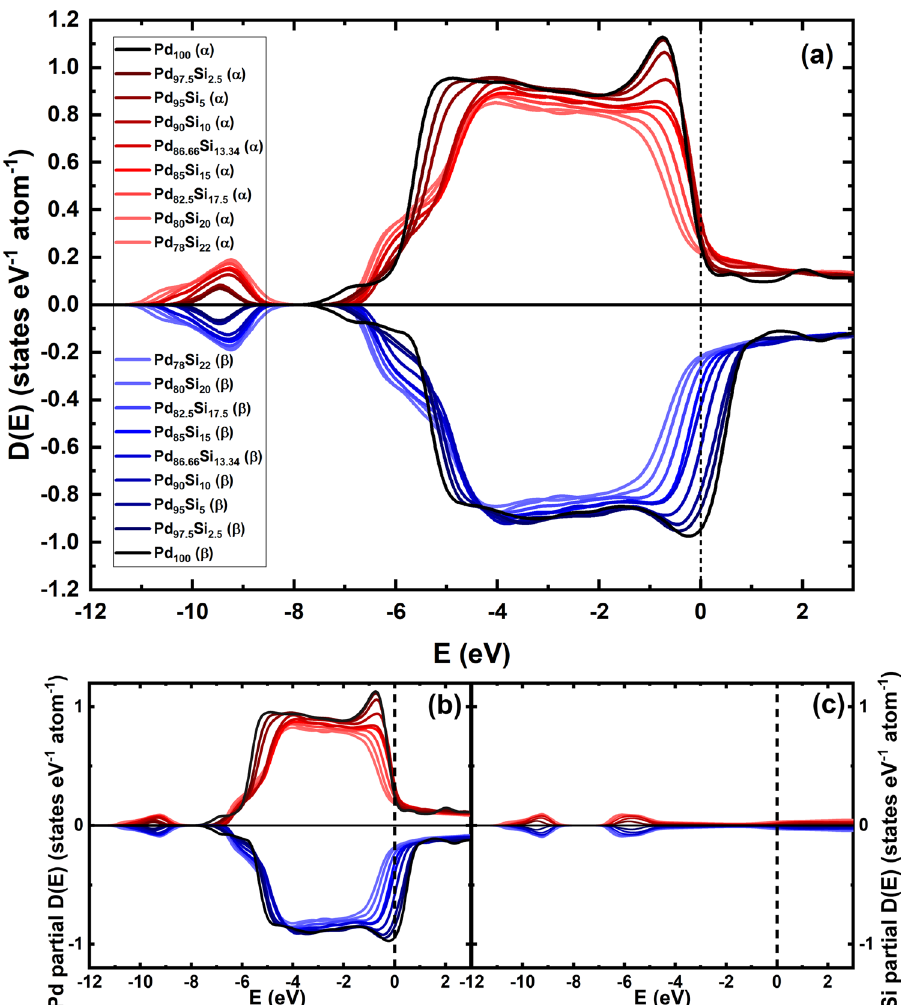
Figure 5. Spin up ( α spins) and spin down ( β spins) densities of states for the 9 supercells. ( a ) Total densities of states. ( b ) Palladium partial densities of states. ( c ) Silicon partial densities of states. The net magnetic moment tends to zero as the silicon concentration